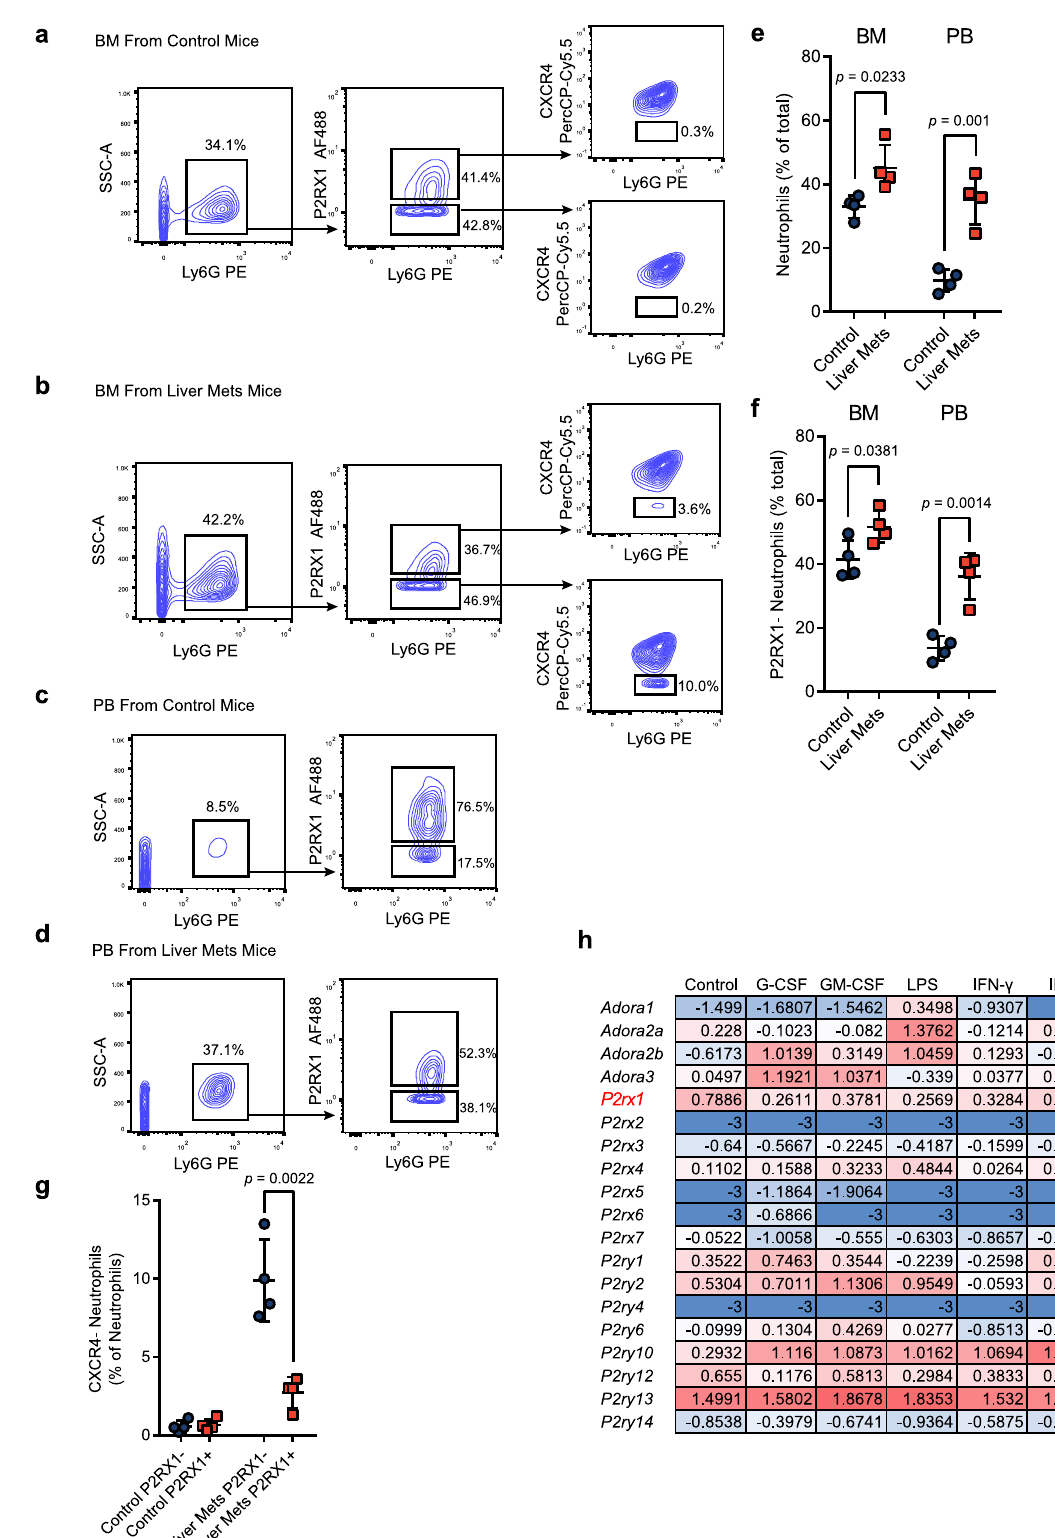
Fig. 4 PDAC liver metastasis systematically mobilizes and recruits P2RX1 − neutrophils. a – g KPC cell was intrasplenically injected to seed livers of WT mice. Bone marrow (BM) and peripheral blood (PB) were obtained at day 17. Frequencies of neutrophils, P2RX1 − neutrophils, and CXCR4 + neutrophils were determined by fl ow cytometry and quantitative results were shown ( n = 4 per group, three independent experiments). h Bone marrow neutrophils were isolated from WT mice and stimulated with indicated stimulus. RNA-seq were performed and Log 2 (FPKM + 0.001) value of purinergic receptors were shown ( n = 1 per group). Bars represent mean ± standard deviation in ( e – g ). P values are derived from two-sided Student ’ s t test ( e – g ). Source data are provided as a Source data fi